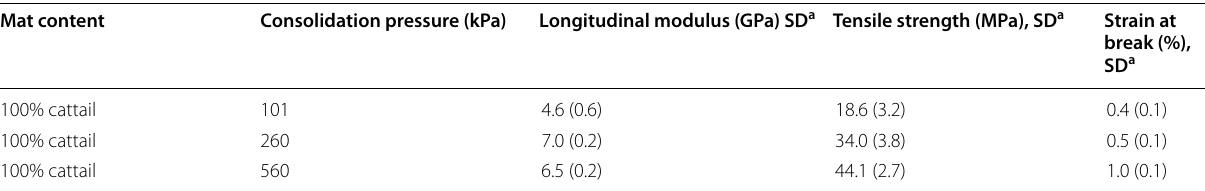
Table 4 Mechanical properties of cattail fiber-reinforced